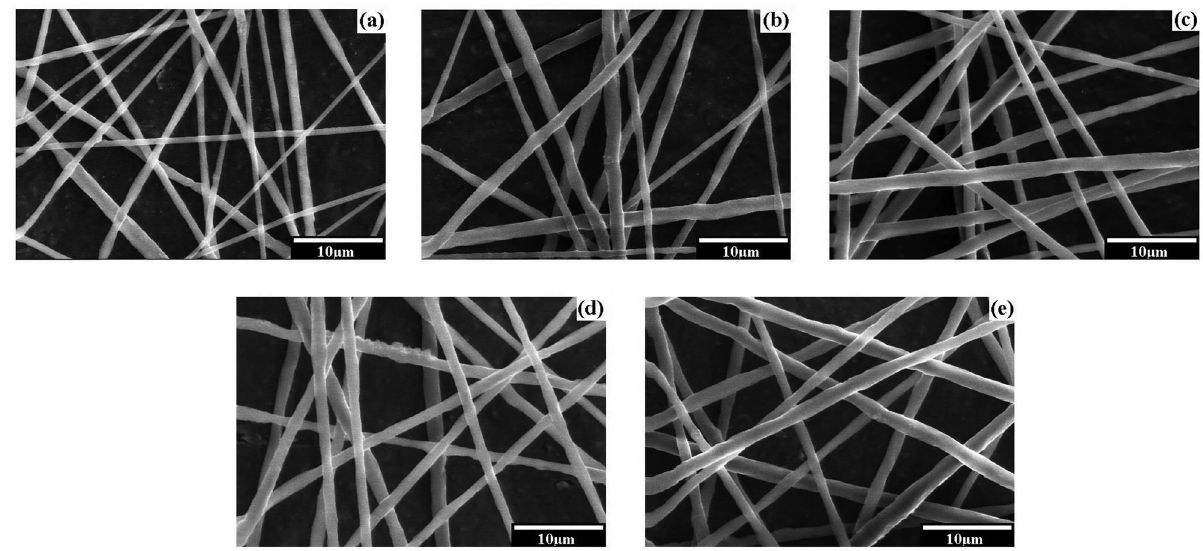
Figure 8: SEM photos of fi bers prepared at the injection speeds: ( a ) 0.2 mL/h, ( b ) 0.3 mL/h, ( c ) 0.4 mL/h, ( d ) 0.5 mL/h, ( e ) 0.6